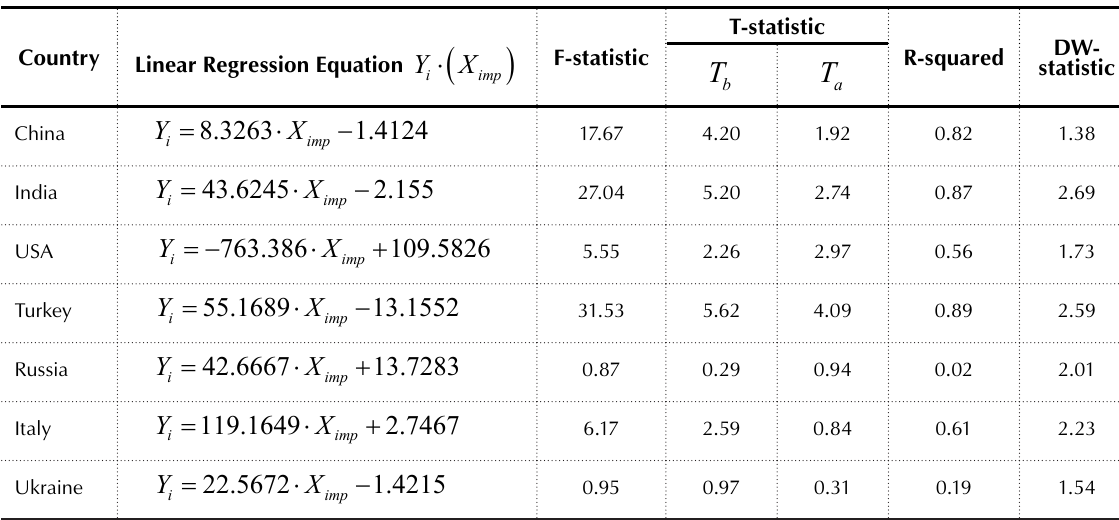
Table 1. Communications import and gross vegetable production for the years 2010–2016 *